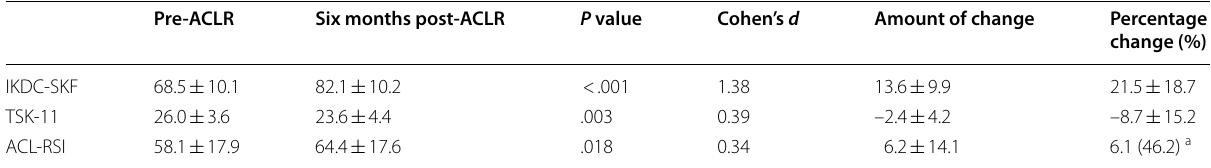
Mean standard deviation, a median (interquartile ±